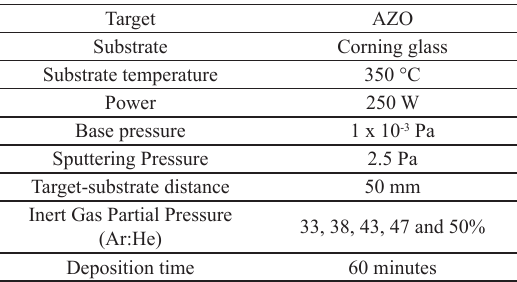
Table 1. Sputtering conditions for preparing AZO thin